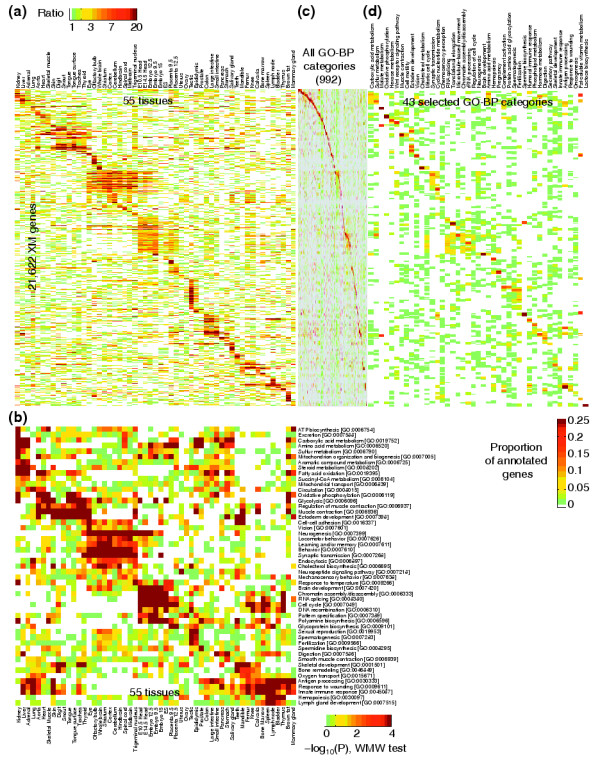
Correspondence between gene expression patterns and GO-BP annotations. (a) Ratios for the 21,622 expressed genes were grouped by two-dimensional hierarchical agglomerative clustering and diagonalization, using the Pearson correlation coefficient. (b) Negative logs of P values resulting from applying the Wilcoxon-Mann-Whitney (WMW) test to each of the GO-BP categories in each of the tissues are shown. The categories (vertical axis) were clustered and ordered as in (a). (c, d) 'Density' of GO-BP annotations significantly enriched in specific points along the vertical axis at left (genes) are indicated; note that genes are in the same order in (a, b, c).